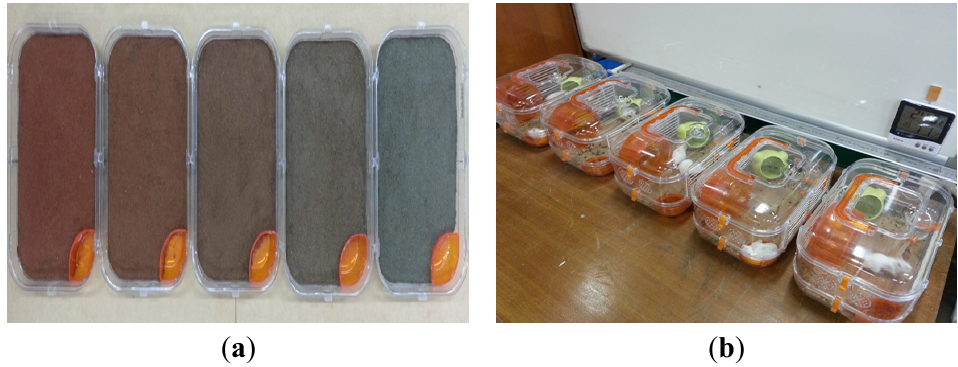
Figure 7. Floor cage photos. ( a ) Casted bottom surfaces and ( b ) Floor cages.